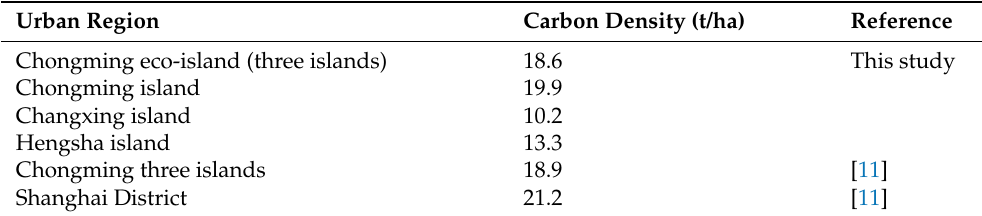
Table 5. Comparison of the urban forest carbon density (t/ha) among cities in China. Urban